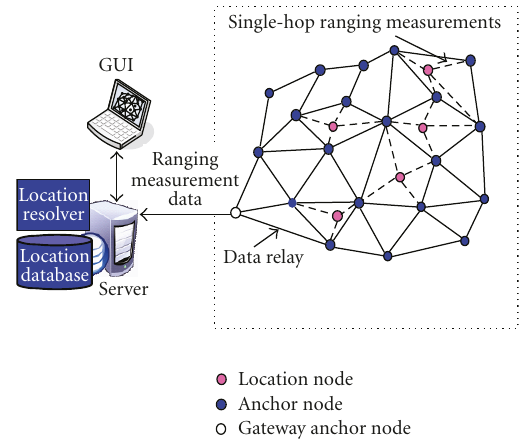
Figure 1: Centralized localization network